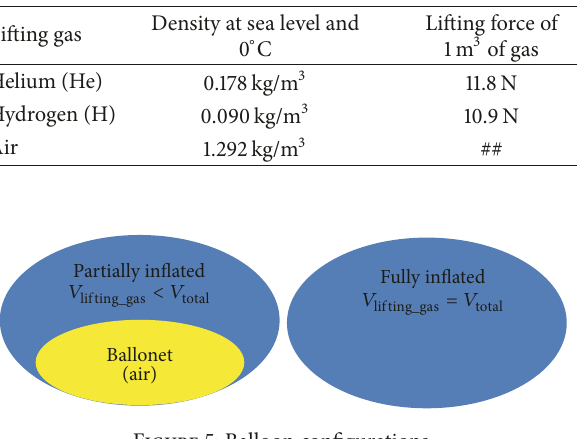
Figure 5: Balloon configurations.